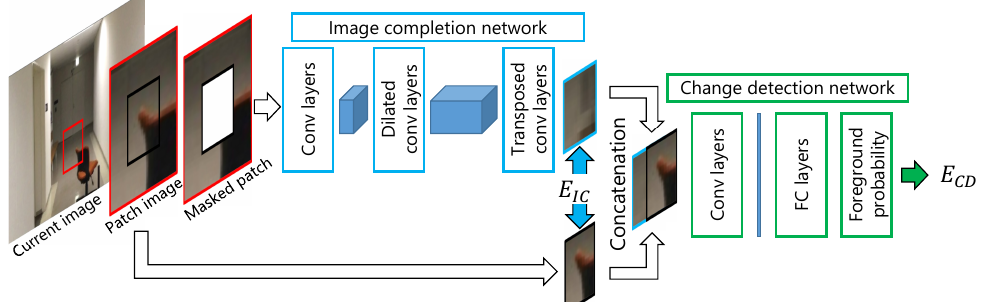
Figure 3. Proposed networks. A patch image is cropped from a current image. After masking the central region of the patch image, the image-completion network receives the masked patch image as an input. The output of the image-completion network and central region of the patch image are concatenated to create the input for the change-detection network. The change-detection network then determines the foreground probability of the patch